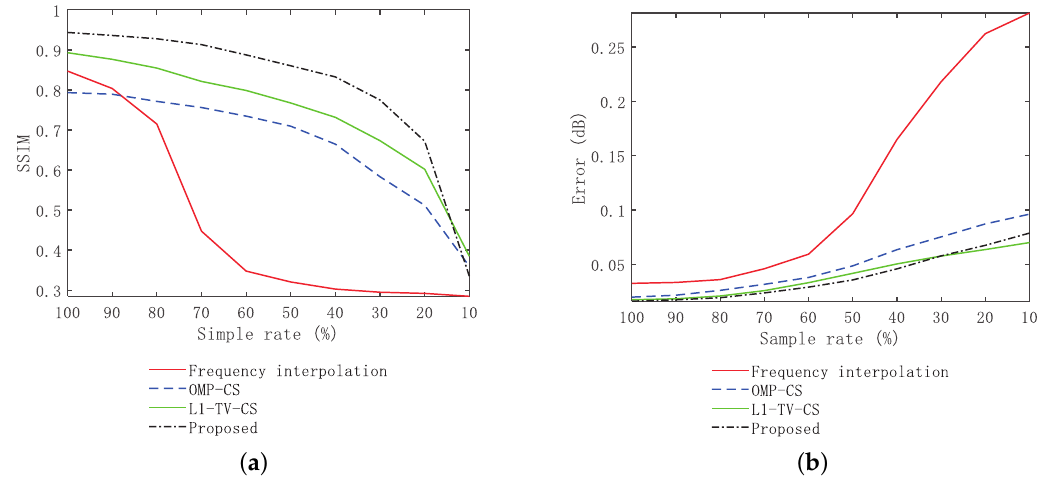
Figure 13. Imaging performance at different sample rates. ( a ) Frequency interpolation method. ( b ) SSIM curve analysis of imaging results.